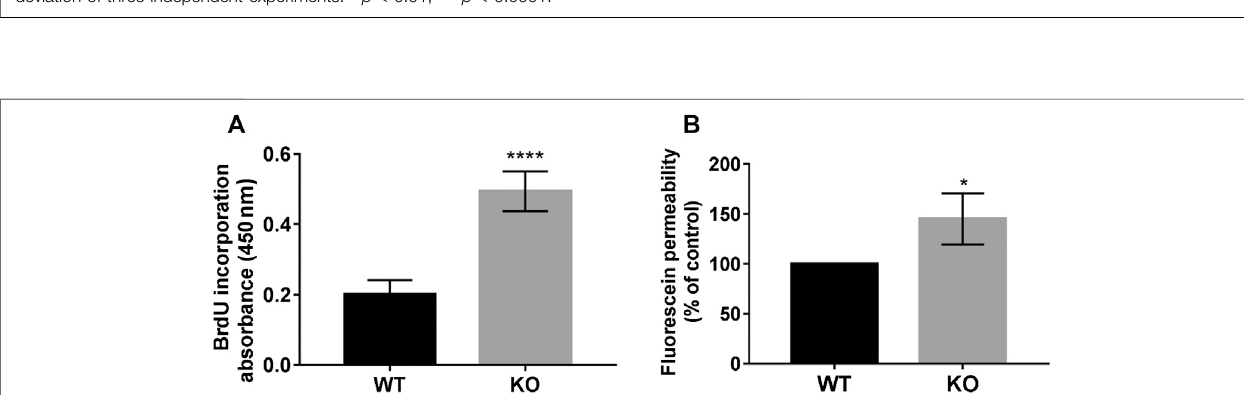
FIGURE 1 | C-terminal fragment of PcdhgC3 accumulates in con fl uent Brain Microvascular Endothelial Cells. BMECs were seeded on gelatin-coated plates and weregrownfor2or7 daysfollowedbyproteinextractionandWesternblot.PcdhgC3proteinlevelwasanalyzedbyWesternblot (A) andthebandscorrespondingtothe full-length protein (130 kDa) (B) and truncated C-terminal fragment of PcdhgC3 (25 kDa) (C) were analyzed by densitometry. Data are shown as mean ± standard deviation of three independent experiments. ** p < 0.01, **** p < 0.0001.